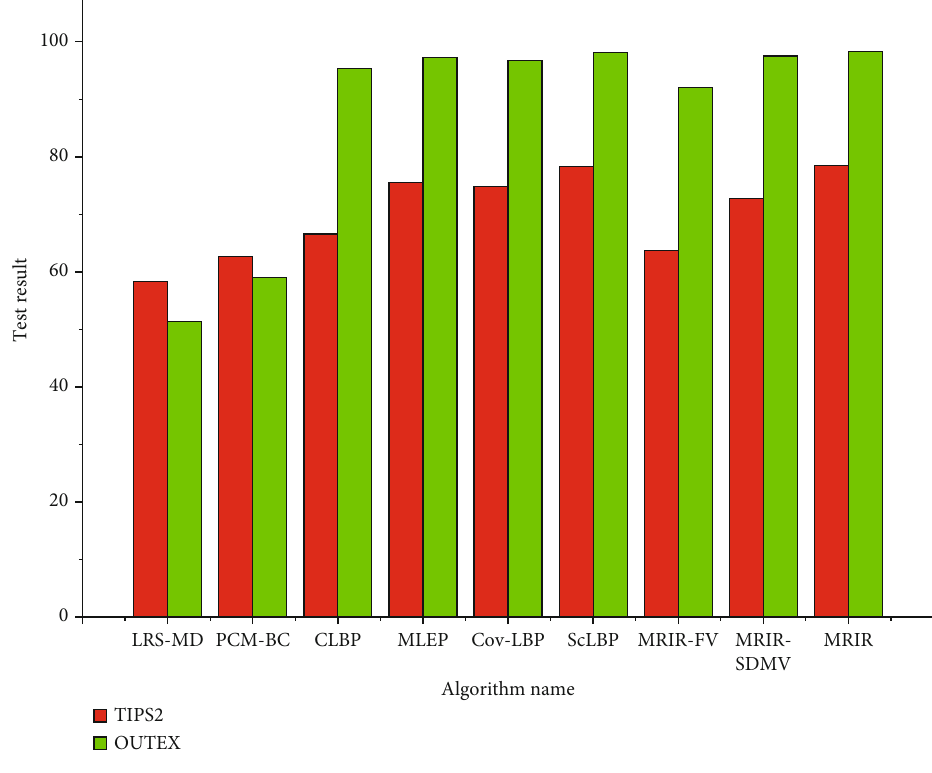
Figure 5: Results of rotational invariance